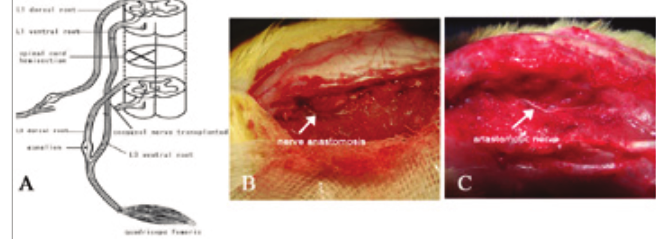
FIGURE 1 – A. Paraspinal neural pathway of quadriceps femoris. B. Anastomosis between the spinal ventral roots. C. Anastomotic nerve six months after